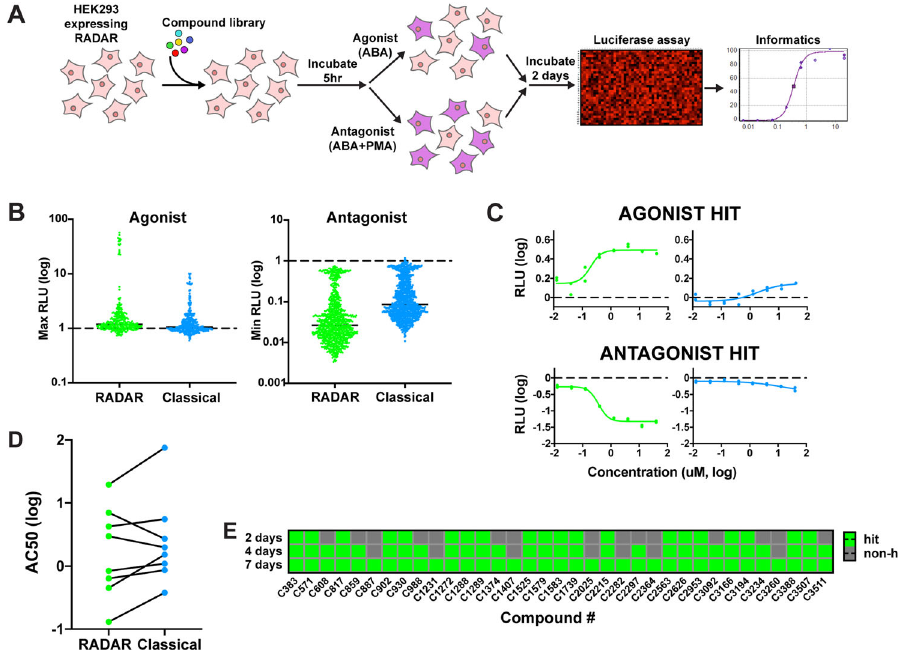
Fig. 2 Application of RADAR to compound screening. A Schematic of the compound screening process. B Maximum and minimum luciferase levels attained by each reporter for each compound in the agonist and antagonist recon fi rmation screens, respectively. RLU values were normalized to the median of the negative controls. RADAR data is depicted in green, and classical reporter data depicted in blue. C Examples of compound hits found by RADAR that were missed by the classical reporter in agonist and antagonist recon fi rmation screens (compounds C3166 and C3394, respectively). All RLU values were normalized to the median of the negative controls ( n = 2). D AC50 values of shared agonist hits between both reporters in the recon fi rmation screen. E Accumulation of speci fi c compound hits in the agonist recon fi rmation screen with 40,000 cells/ml cell density over